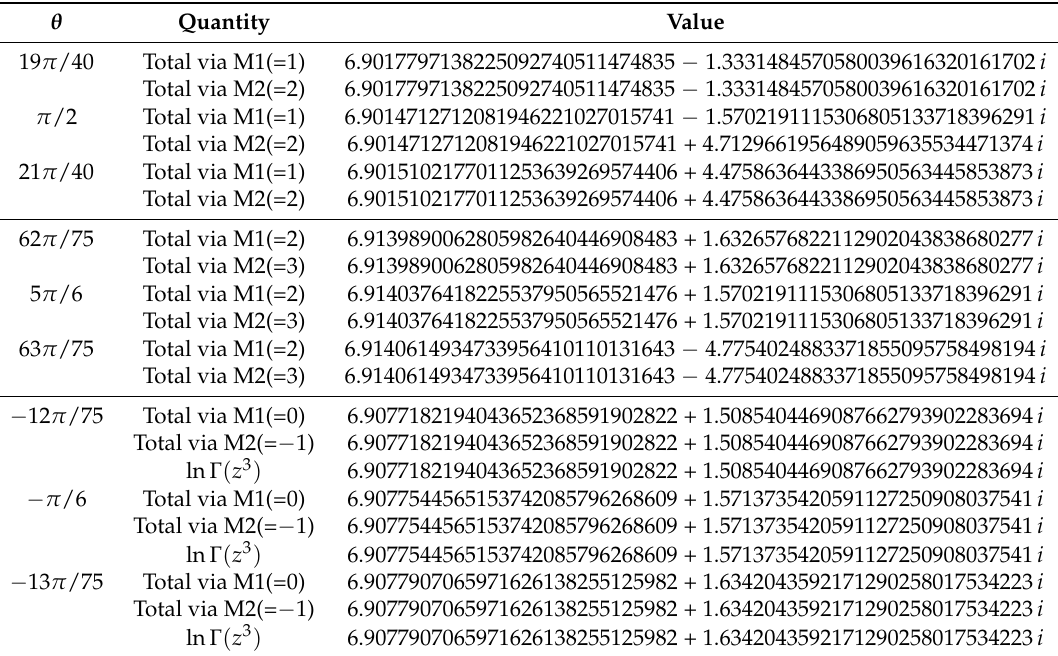
Table 7. ln Γ ( z 3 ) via the MB-regularized forms in the vicinity of the lines of discontinuity given by θ = π /6, θ = π /2 and θ = 5 π /6 with −